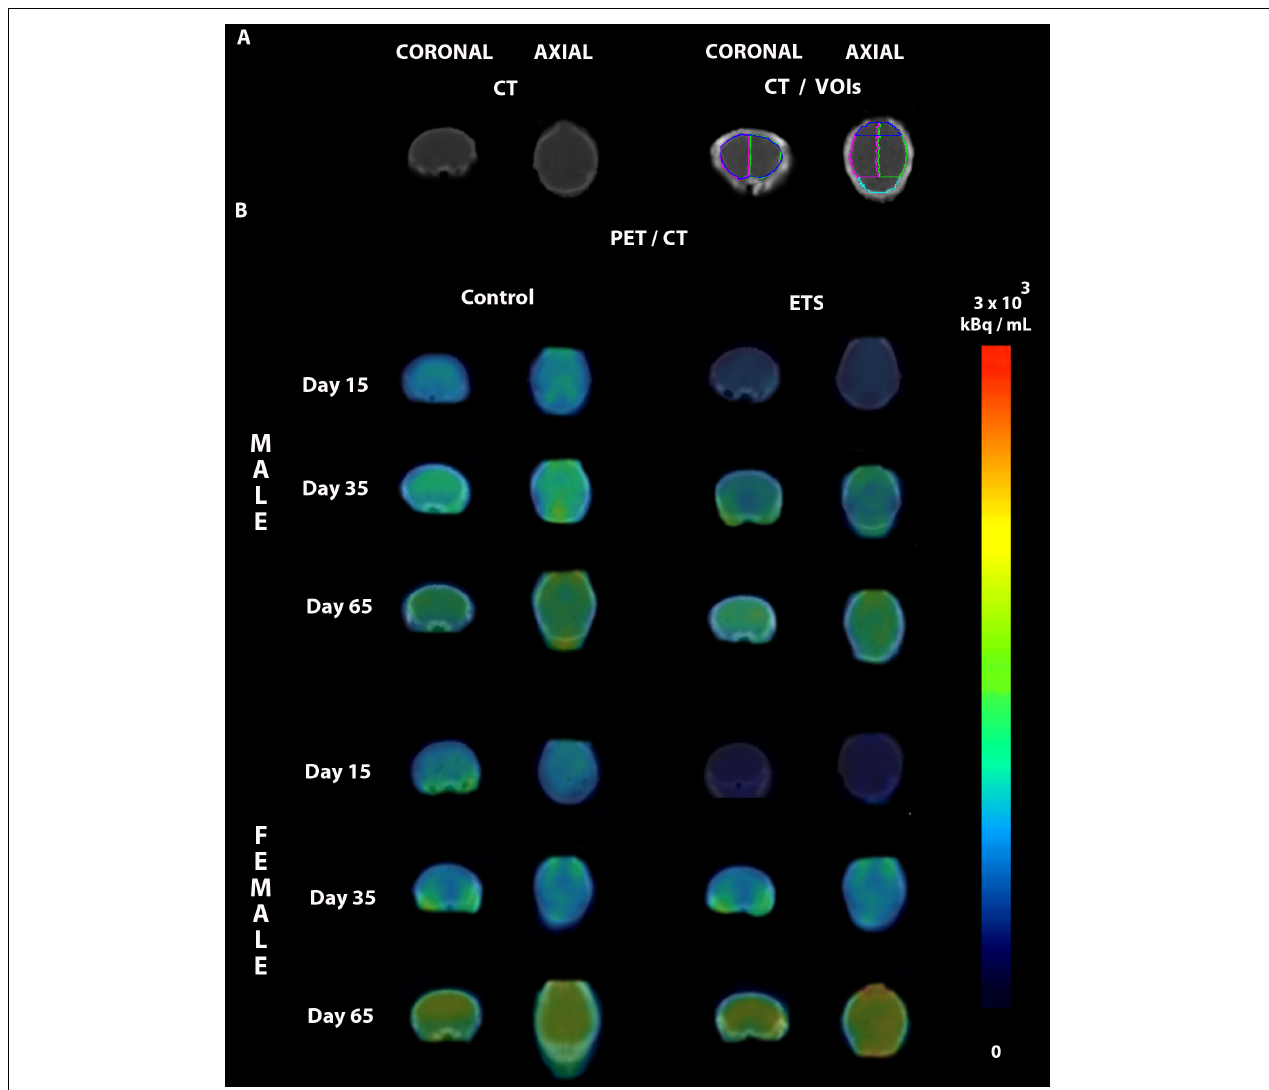
FIGURE 2 | Representative PET/CT brain images of male and female mice exposed to ETS during the early postnatal period and the control group. (A) CT images in different anatomical planes in the top left, and CT with the drawn volumes of interest (VOIs) used for quantification in the top right (whole brain, left hemisphere, right hemisphere, frontal cortex, and cerebellum). (B) PET images fused to the CT images of infant (Day 15), adolescent (Day 35), and adult (Day 65) male and female mice of the control and ETS